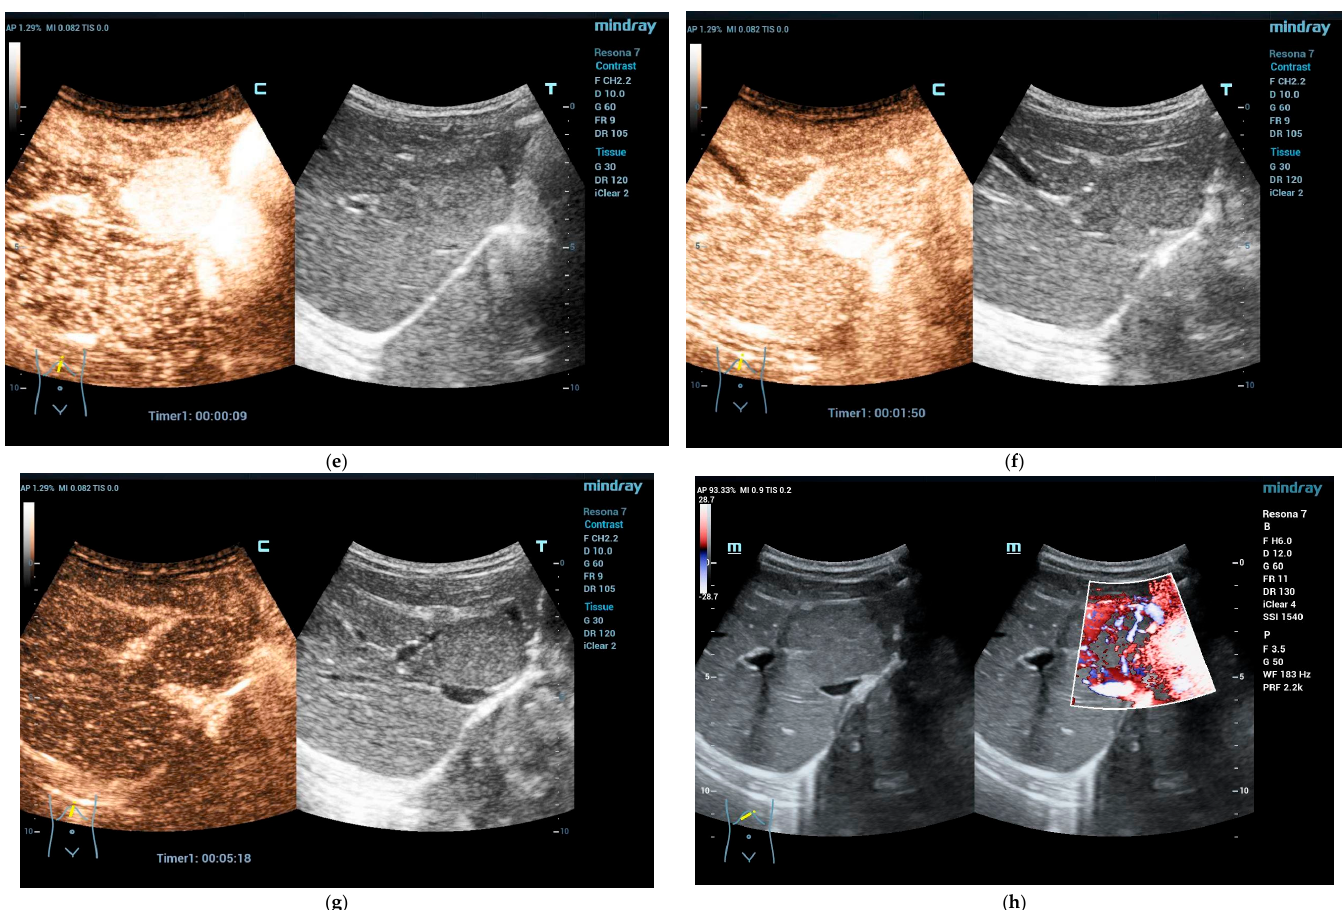
Figure 2. 2-year-old girl, incidentally detected FLL. Referred to our hospital for biopsy of the mass. On B-mode 34 mm × 30 mm a well circumscribed homogenous FLL visible in the left lobe ( a ). Color flow Doppler showed centripetal spoke wheel presentation ( b ), more prominent on power Doppler mode ( c ). Contrast-enhanced ultrasound in the early arterial phase reveals very fast arrival time with central artery and spoke wheel pattern ( d ) with complete fill and hyperenhancement a few seconds later ( e ). In the portal venous phase homogeneous isoenhancement ( f ). No washout in the late phase ( g ). Focal nodular hyperplasia diagnosed; biopsy declined. On follow-up, the mass remains the same in three years ( h ) (SC5-1U